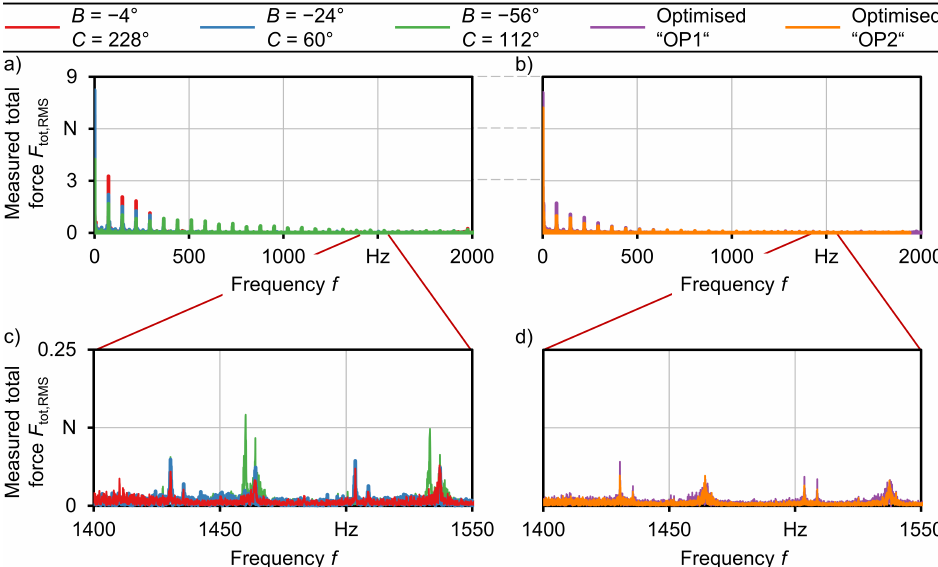
Figure 16. RMS values of the process forces measured in the validation experiments for ( a , c ) fixed B and C orientation and ( b , d ) two optimised